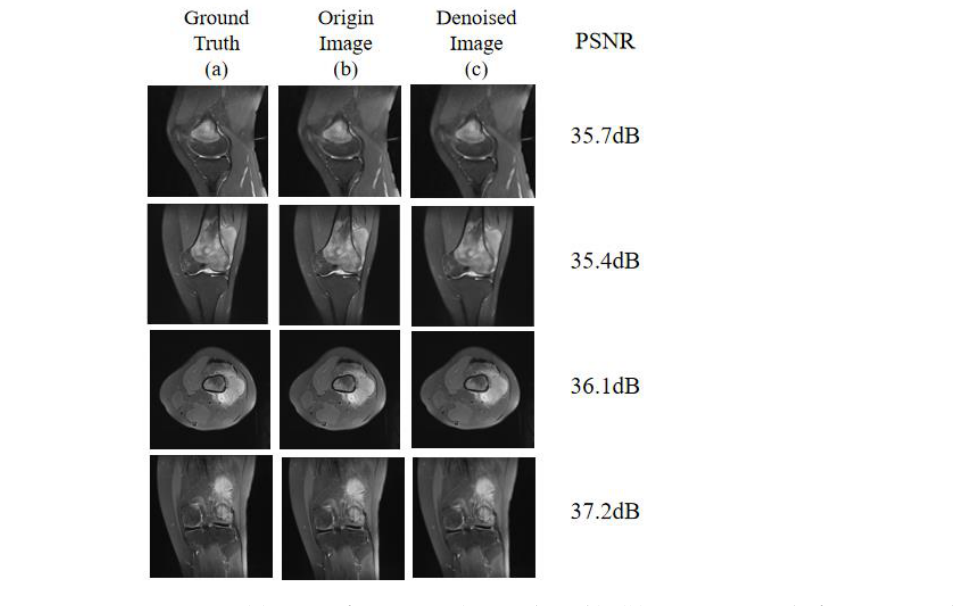
Figure 7. ( a ) Noise-free image (ground truth), ( b ) origin image before noise reduction, ( c ) recon- structed image after noise reduction.